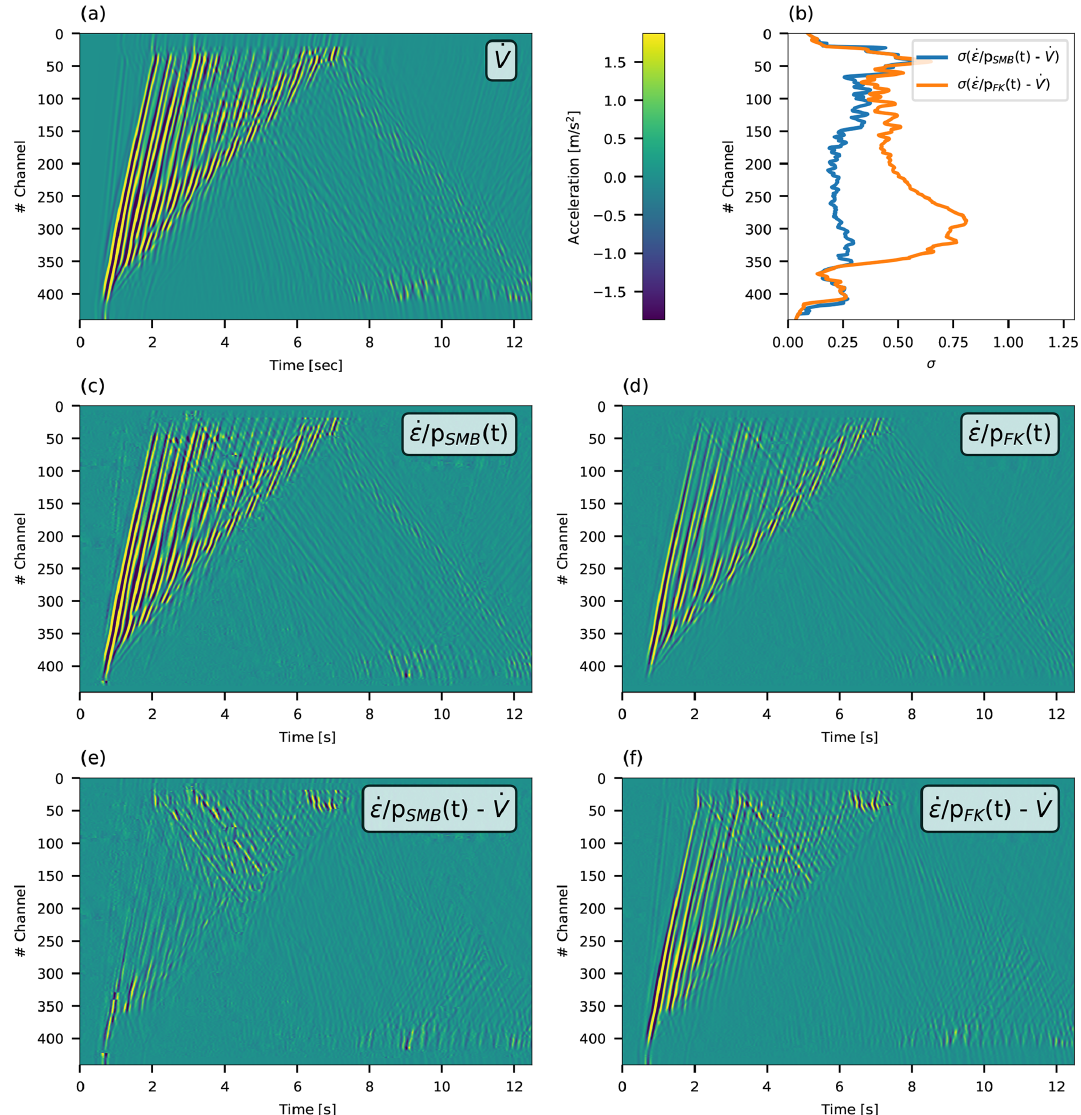
Figure 4. Comparison between simulated velocities time-differentiated to accelerations (a) , and simulated velocities space-differentiated to strain rate and converted to ground accelerations: using semblance-derived slowness (c) and FK-derived (d) . Panel (e) shows the residuals between accelerations in (c) and (a) , and (f) shows the residuals between accelerations in (d) and (a) . Standard deviations of the residuals for each recorded channel are plotted in (b) for the residuals in (e) (blue curve) and in (f) (orange curve). The color code is uniform for (a) and (c–f) and indicated in the color bar in the top